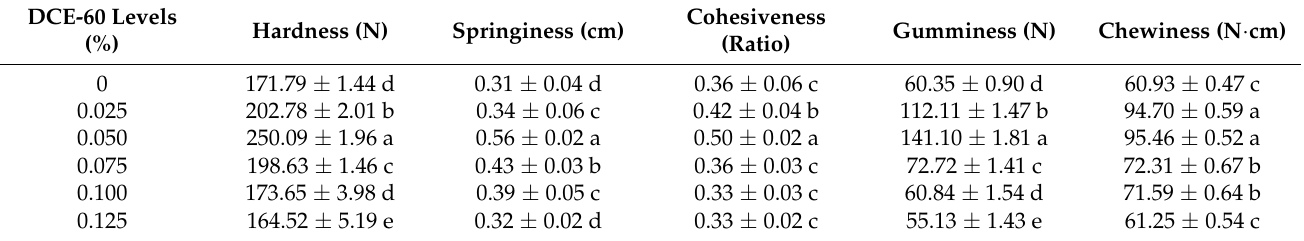
Table 3. Textural profile of sardine surimi gel added without and with DCE-60 at different